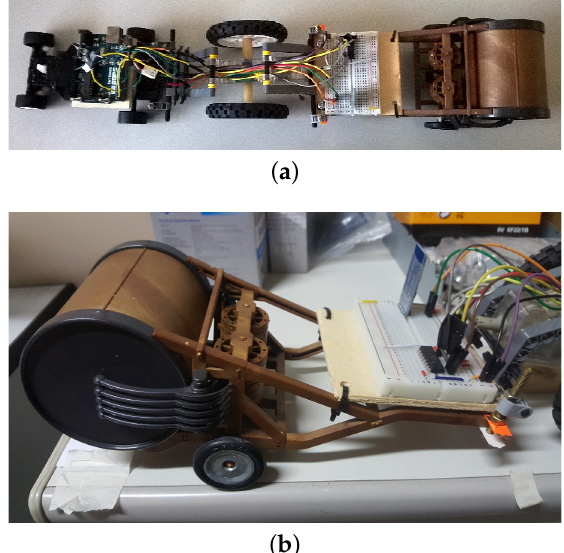
Figure 6. Machine 6, the Mechanical Drum: ( a ) view from above of the automated machine; ( b ) the Leonardo mechanical drum and the microcontroller board with bluetooth